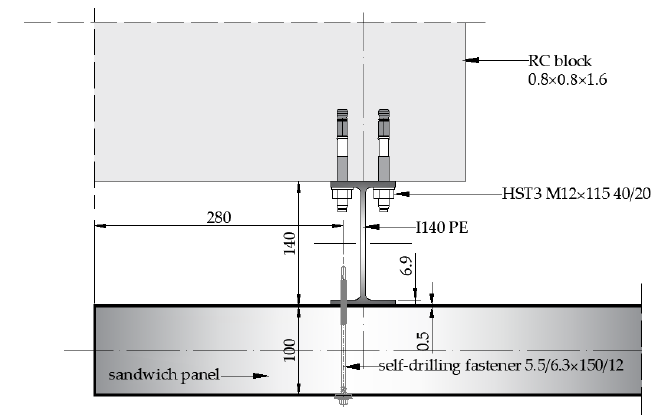
Figure 3. Detail of the connection of the sandwich panel with the I140 PE column (dimensions are in mm).